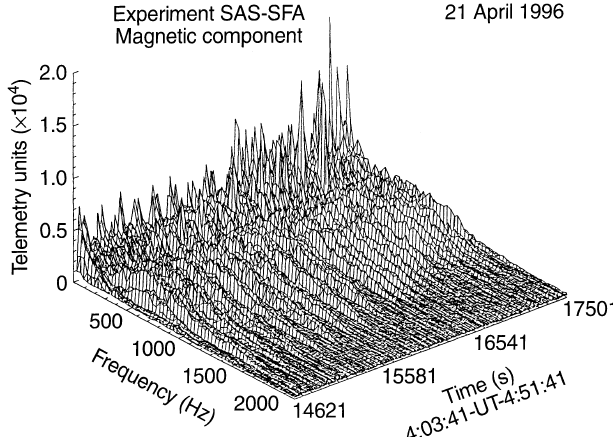
Fig. 6 . The same as Fig. 2 during the flight within the polar cusp